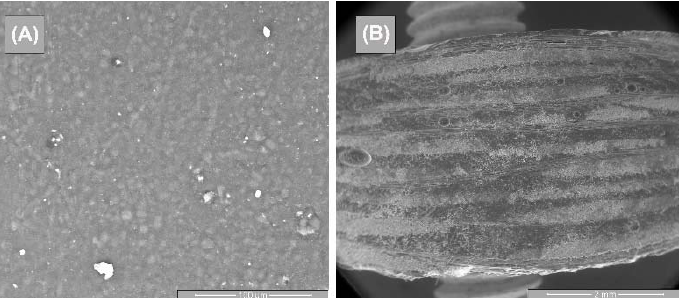
Figure 12. SEM images of the base material—GFRP: ( A ) surface image and ( B ) cross ‐ section image.